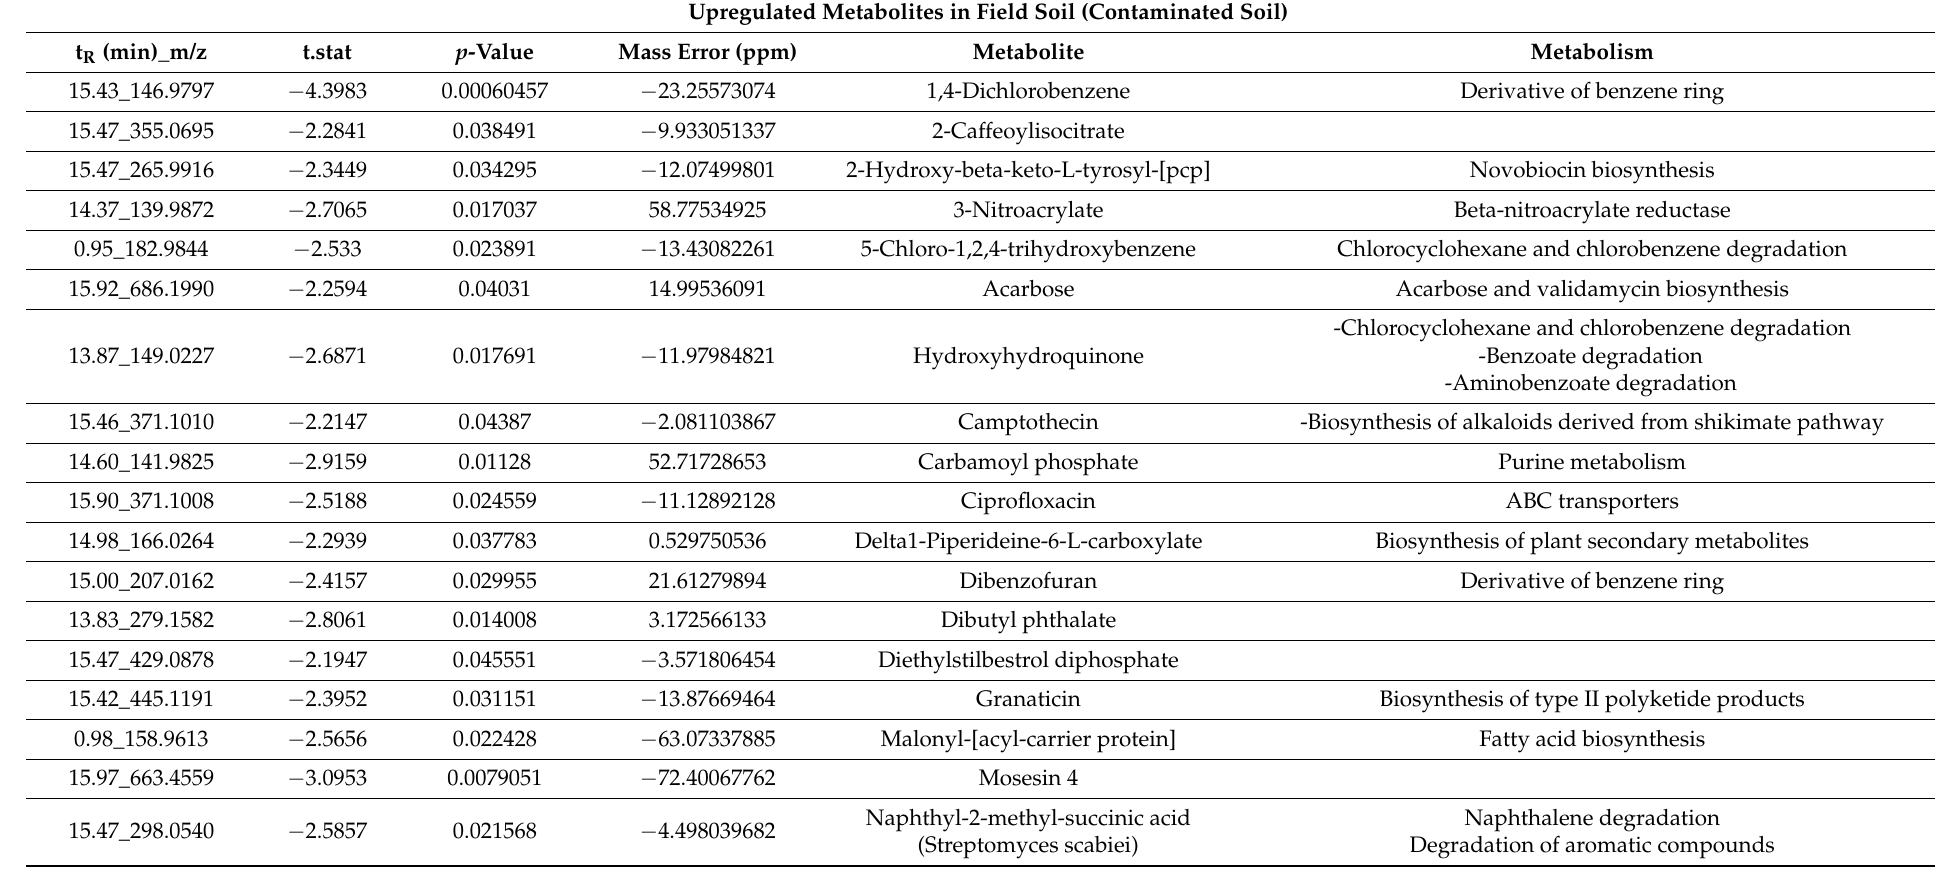
Table 4. Up- and downregulated metabolites in field soil; upregulated metabolites of group B in Figure 4 are presented in first part of Table 4 and downregulated metabolites of group A in Figure 4 are presented in second part of Table 4. Metabolites less than p -value 0.05 are significant statistically. t.stat value was calculated from the t -test, and the higher the absolute value of t.stat, the greater the difference in intensities of metabolites when comparing control soil and field soil